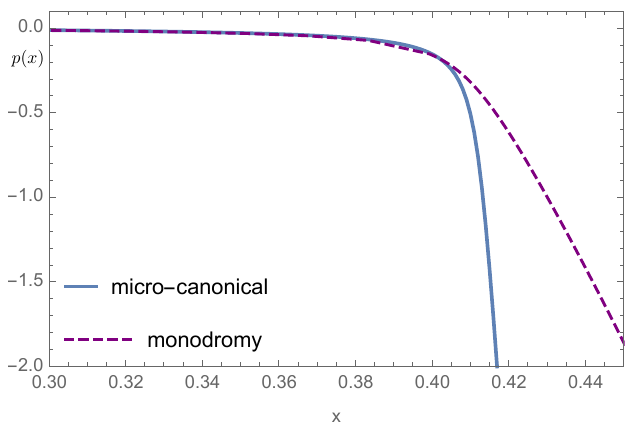
3 ; x ). Blue is the micro-canonical ensemble results; purple Figure 8 . Plots of p ( (cid:15) H = 36 ; (cid:15) L = 10 (cid:0) is the result from the monodromy